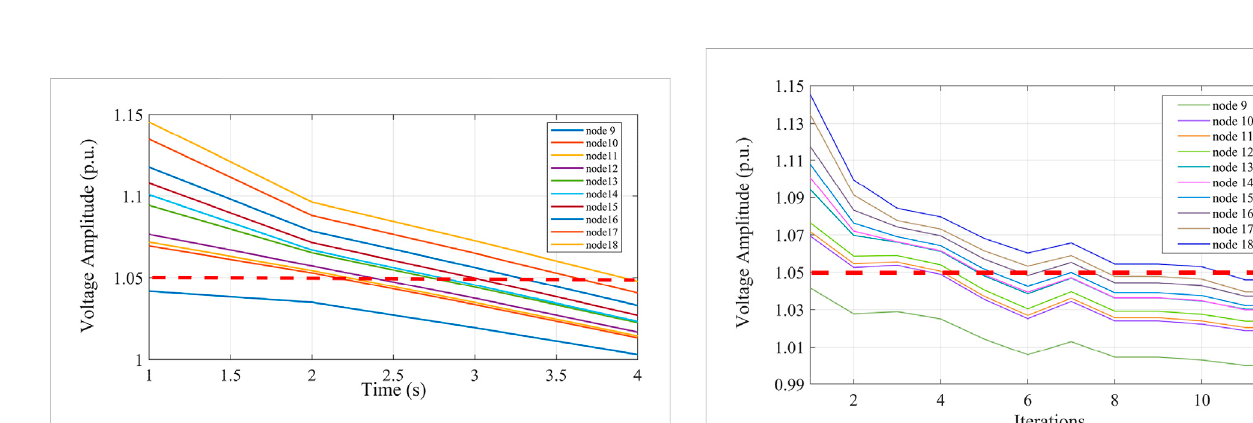
FIGURE 14 Voltage control effect when active power reduction is added.